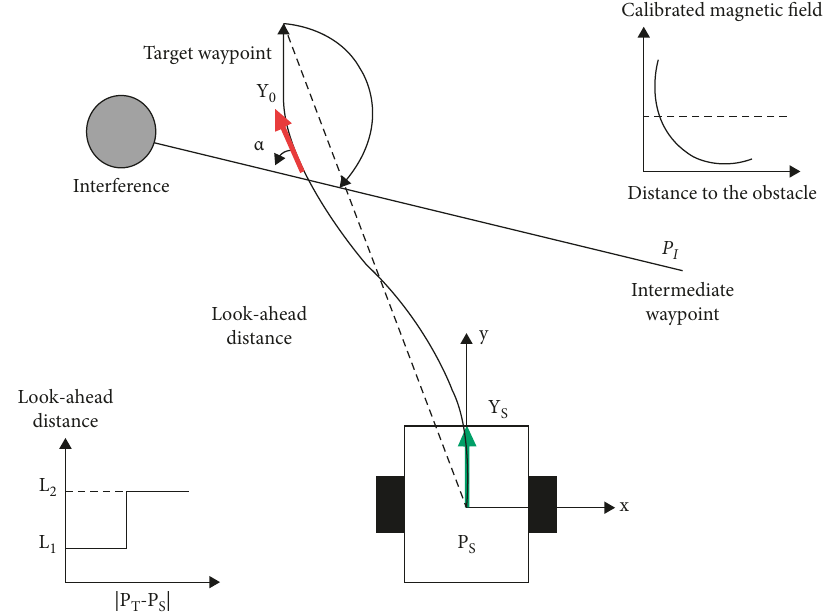
Figure 5: Interference avoidance behavior of integration.